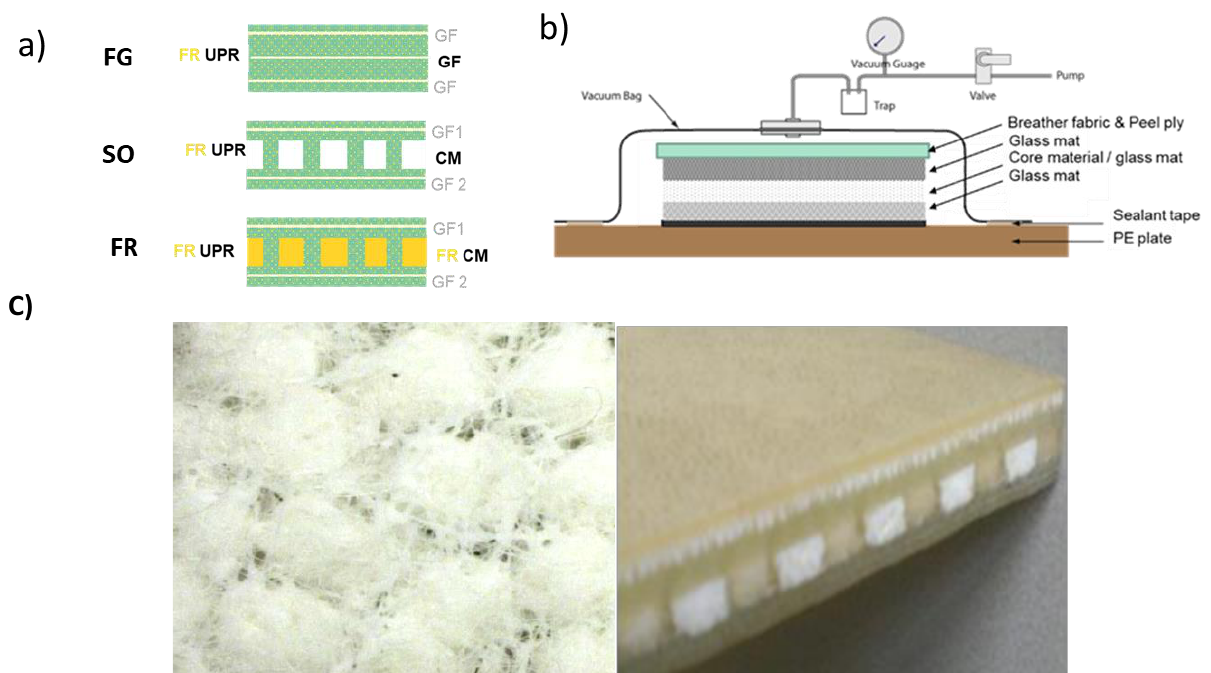
Figure 2. Schemes of ( a ) the build-up of the laminates and ( b ) the lamination process by vacuum bagging and ( c ) pictures of the SORIC showing its pattern and that of a composite made with it.